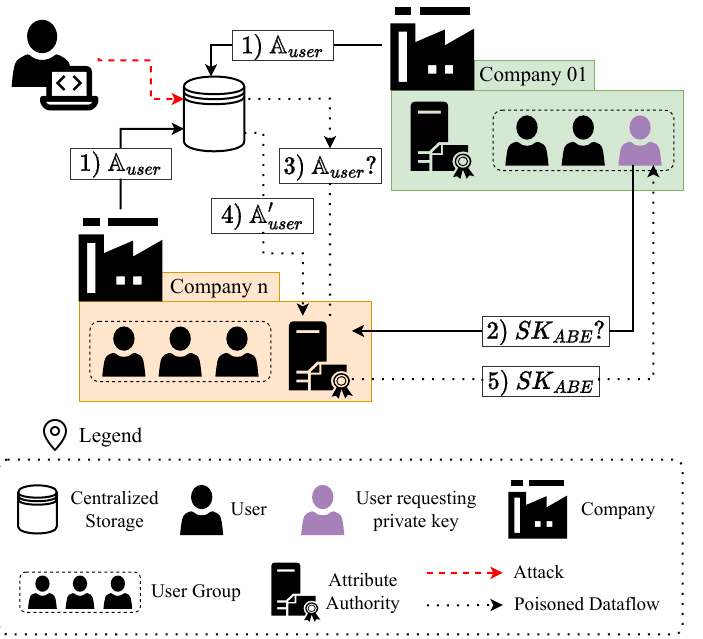
Figure 1. AV 2—Interfering with the Attribute Storage. The attacker poisons the database, resulting in the user getting SK (cid:48) instead of SK ABE ABE